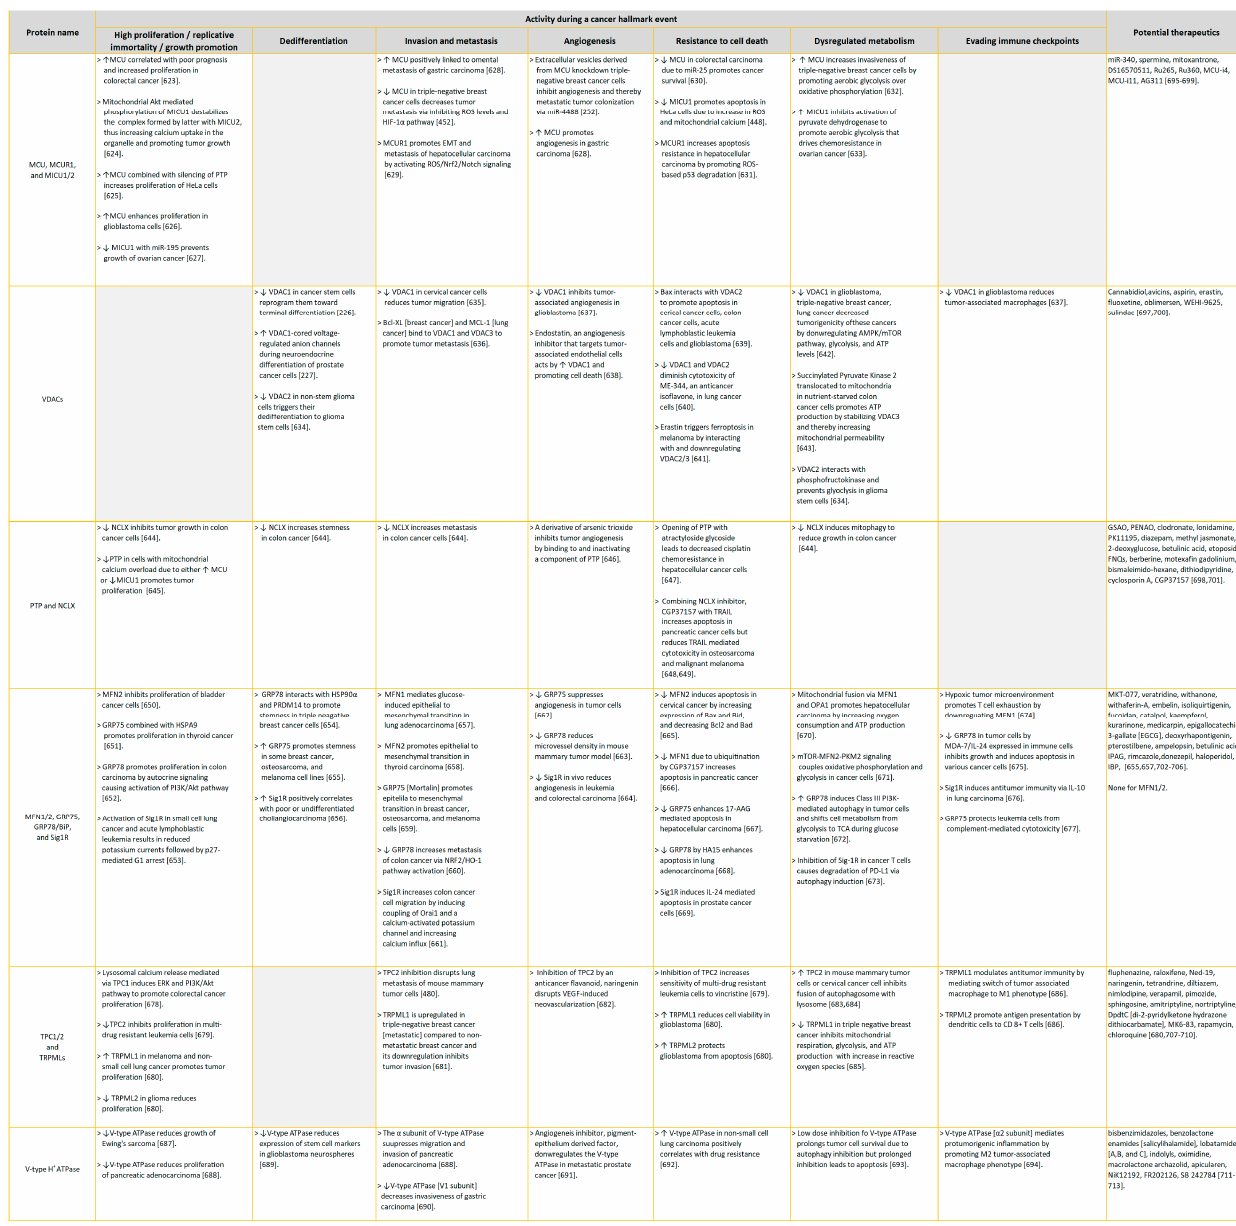
Figure 12. Roles of intracellular calcium regulators in cancer and potential therapeutics. Even after decades of research on intracellular Ca 2+ in tumor cells, the vast clinical potential of targeting key players in this area remains underappreciated. Whether it is through redesigning existing therapeutics or developing novel treatments for directly modulating the intracellular Ca 2+ levels, greater efforts are needed to find ways to reverse the hijack of intracellular Ca 2+ signaling in cancer.